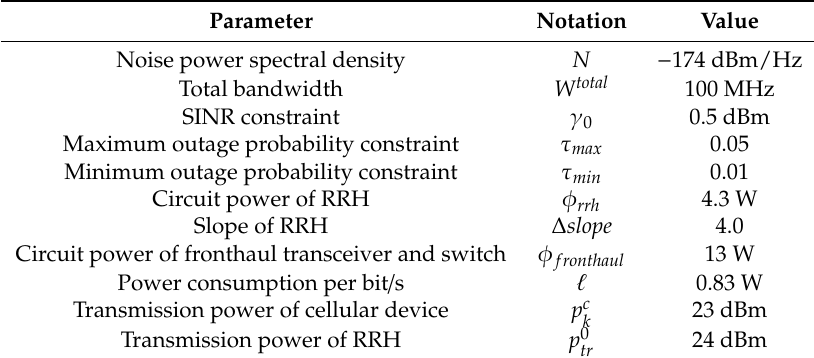
Table 1. Parameters used in the